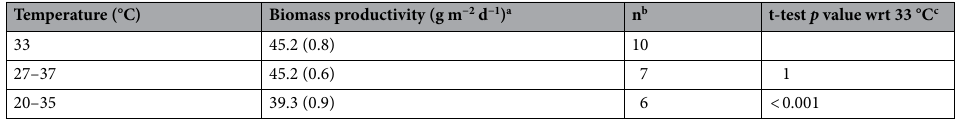
Table 2. Diel biomass productivity of Picochlorum celeri at 35 PPT marine salt concentration in dense- culture medium as a function of temperature. a Standard error is given in brackets. b n represents the number of replicates for each condition. c Gives the t-test p value for each concentration with respect to growth rates at 33 °C.